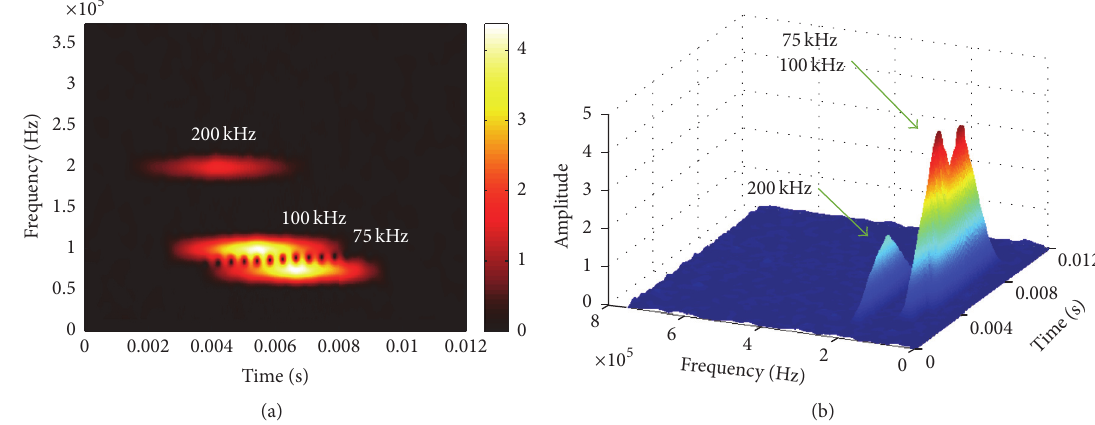
Figure 5: The STFT representation with a short window of the sample signal: (a) two-dimensional figure and (b) three-dimensional